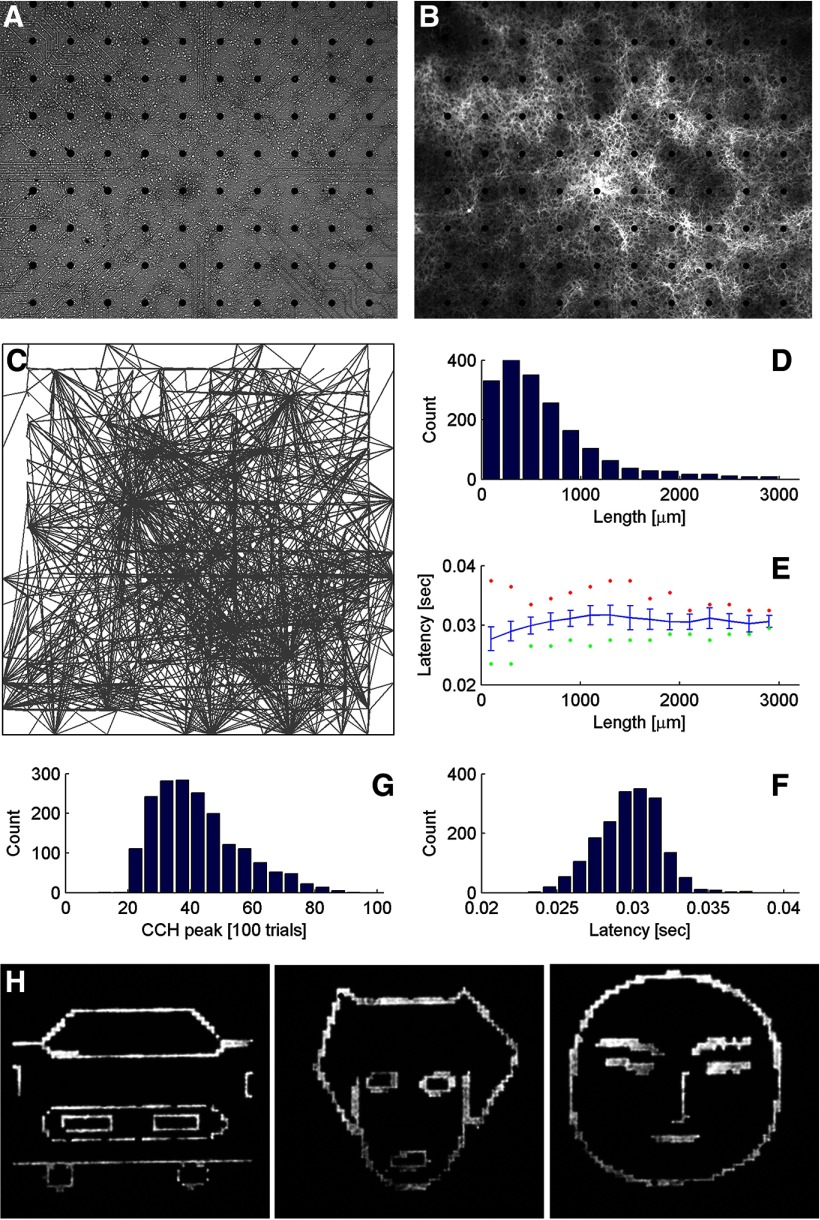
 Network connectivity and stimulus pattern. A, B, Pictures of a DIV30 MEA culture taken with a 4× objective illuminated by bright-field light (A) and fluorescent light (510 nm with 3-s exposure time) to visualize ChR2-YFP expression (B). C–G, Network connectivity summary of the MEA culture. C, All significant connections detected by CCH probing. Each line is drawn from a presynaptic dot position to a postsynaptic electrode. D, Histogram of the distances of the connections in C, binned at 200 µm, which is the spacing between two adjacent electrodes. E, Group average latency of the corresponding connections in D. Error bars indicate the SDs. Max and min latencies are marked as red and green. F, Histogram of the latencies of the connections. G, Histogram of the CCH peak values of the connections. The value is normalized to 100 trials. A peak at 100 means for every trial when the presynaptic dot position was stimulated, the postsynaptic electrode detected a response. Connection efficacy is positively correlated with the CCH peak, but to be more precise, we used the area under the PSTH curve as the measure of connection efficacy in the subsequent analyses. H, Cartoon-like images of a car front, a dog face and a human face, projected as blue light patterns onto an MEA culture with ChR2-YFP expressing neurons.